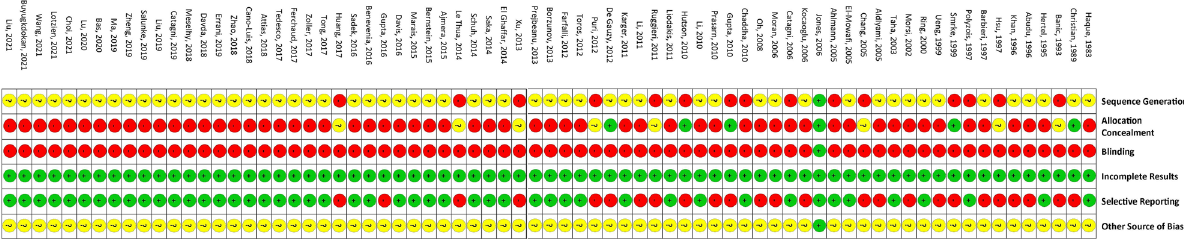
Figure 4. Risk of bias of all the included studies, evaluated in accordance with the Rob 2.0